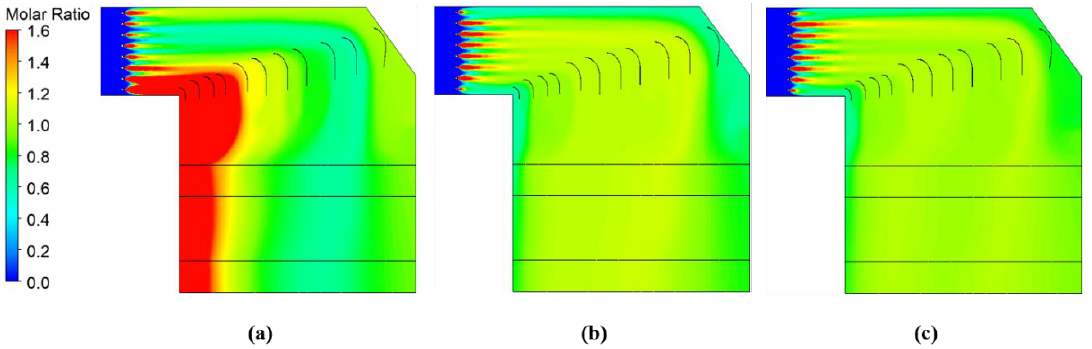
Figure 15. Distribution of NH 3 /NO around the flow passage for the upper-skewed profile. ( a ) Constant injection; ( b ) adjusted injection; ( c ) optimized injection.